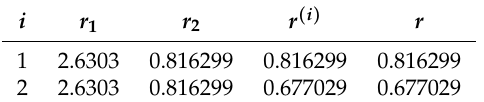
Table 1. Distinct radii of convergence.